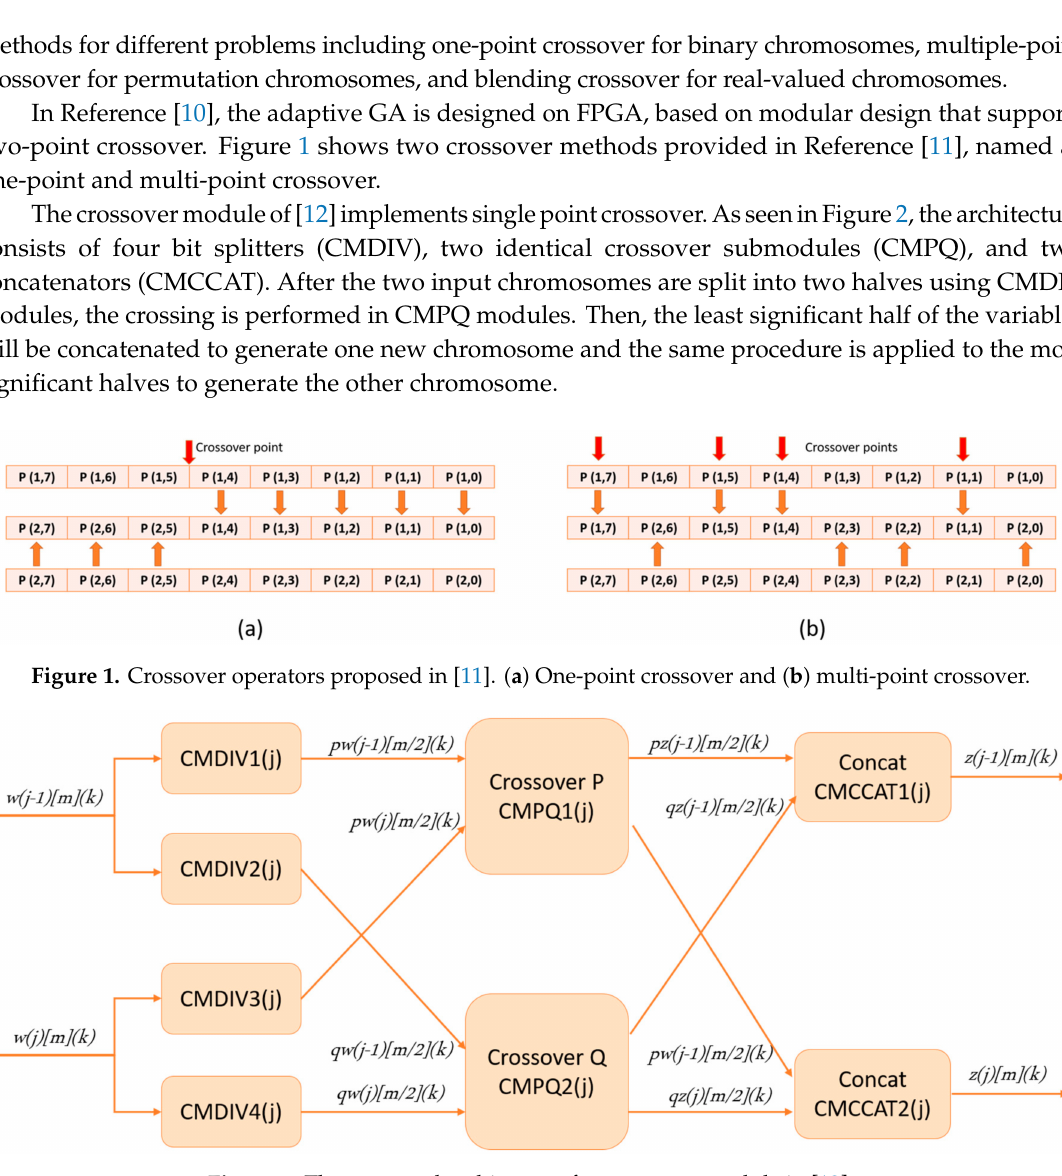
Figure 2. The proposed architecture for crossover module in